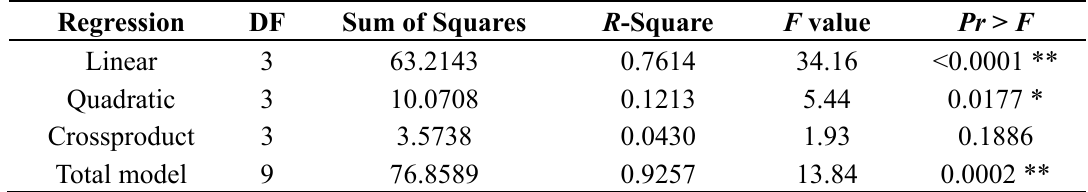
Table 3. Analysis of variance (ANOVA) for the full quadratic model for optimization of ganoderic acid Me (GA-Me) production in G. lucidum .